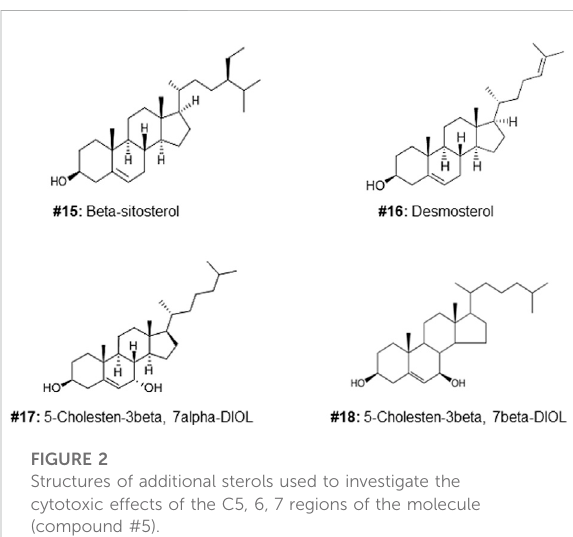
FIGURE 2 Structures of additional sterols used to investigate